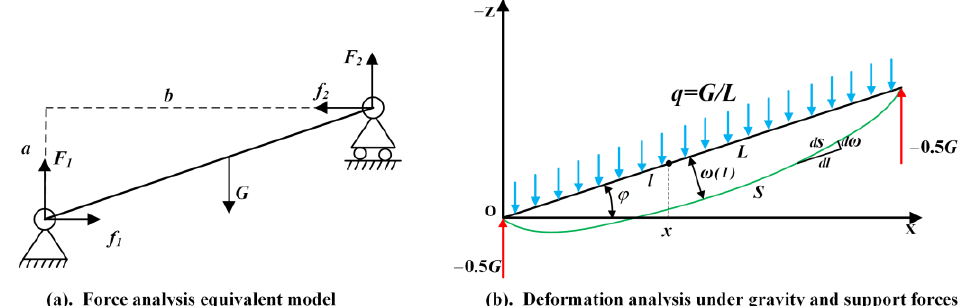
Figure 5. Analysis of force and deformation of truss rod.